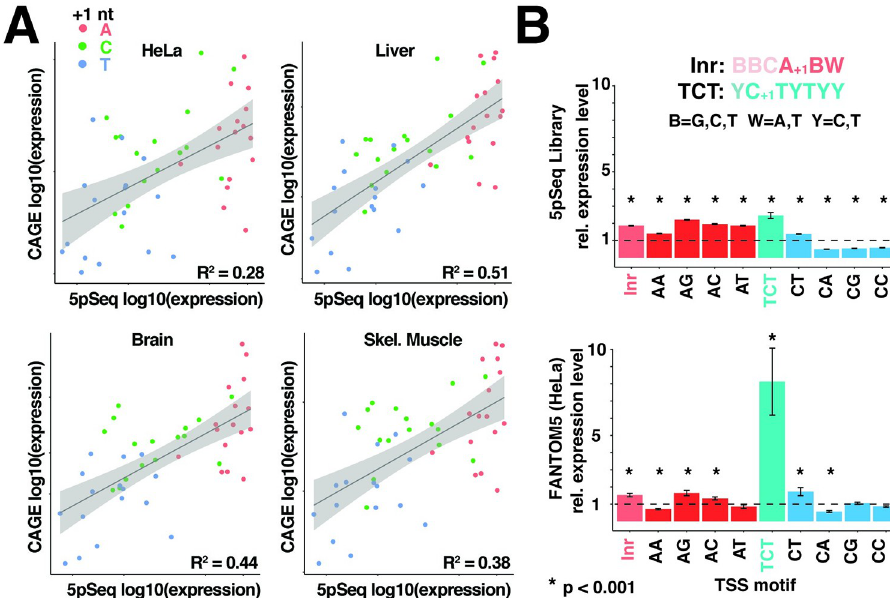
Fig 3. Expression levels of library TSSs correlate with endogenous TSSs. (A) Comparison of library and endogenous TSS expression. CAGE reads from HeLa cells and the indicated human tissues were extracted from the 1 kb region surrounding the 5 0 ends of annotated transcripts and used to determine the frequencies of 5 0 3-mer sequences. CAGE 3mer frequencies were then compared to library 3mer frequencies from Fig 2A. Significance level of p < 10 − 5 for all plots. (B) AG and CT are preferred TSS sequences in library and endogenous mRNAs. Expression levels of the indicated di-nucleotide motifs were compared to classical Inr and TCT sequences for library and endogenous TSSs. Significance determined by t-test, compared to mean expression of all TSS sequences (indicated as a dashed line).